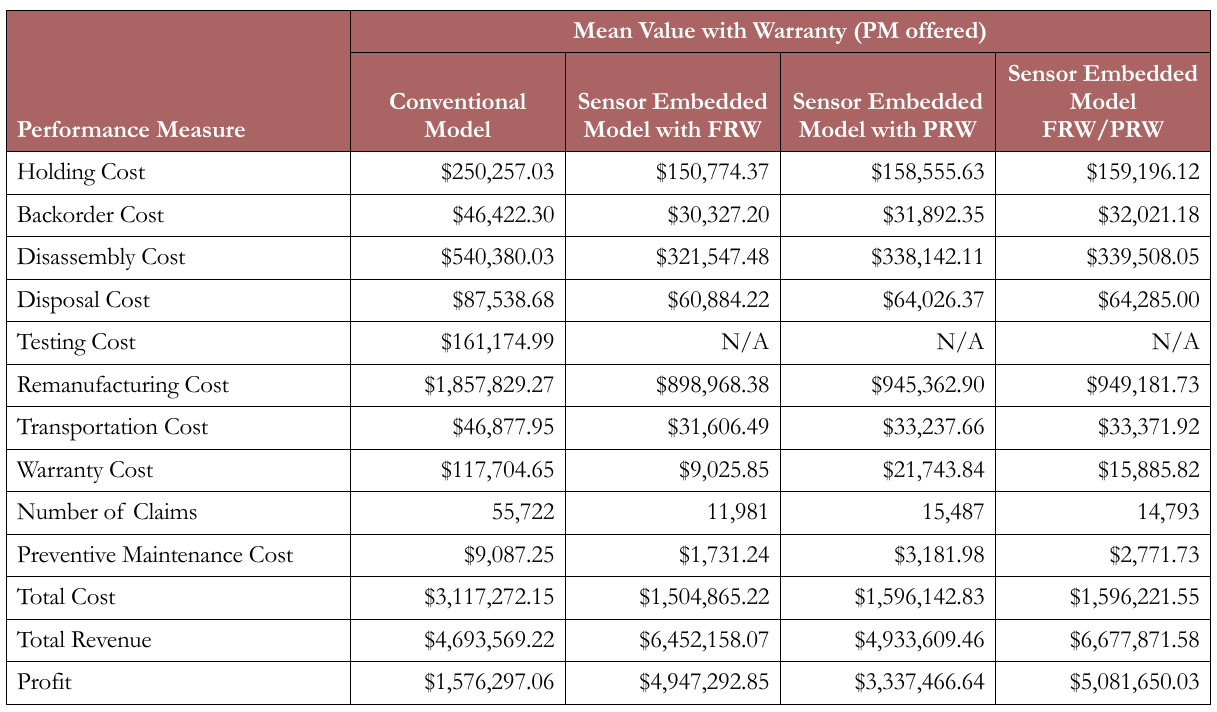
Table 5. Results of performance measures for different models with warranty and preventive